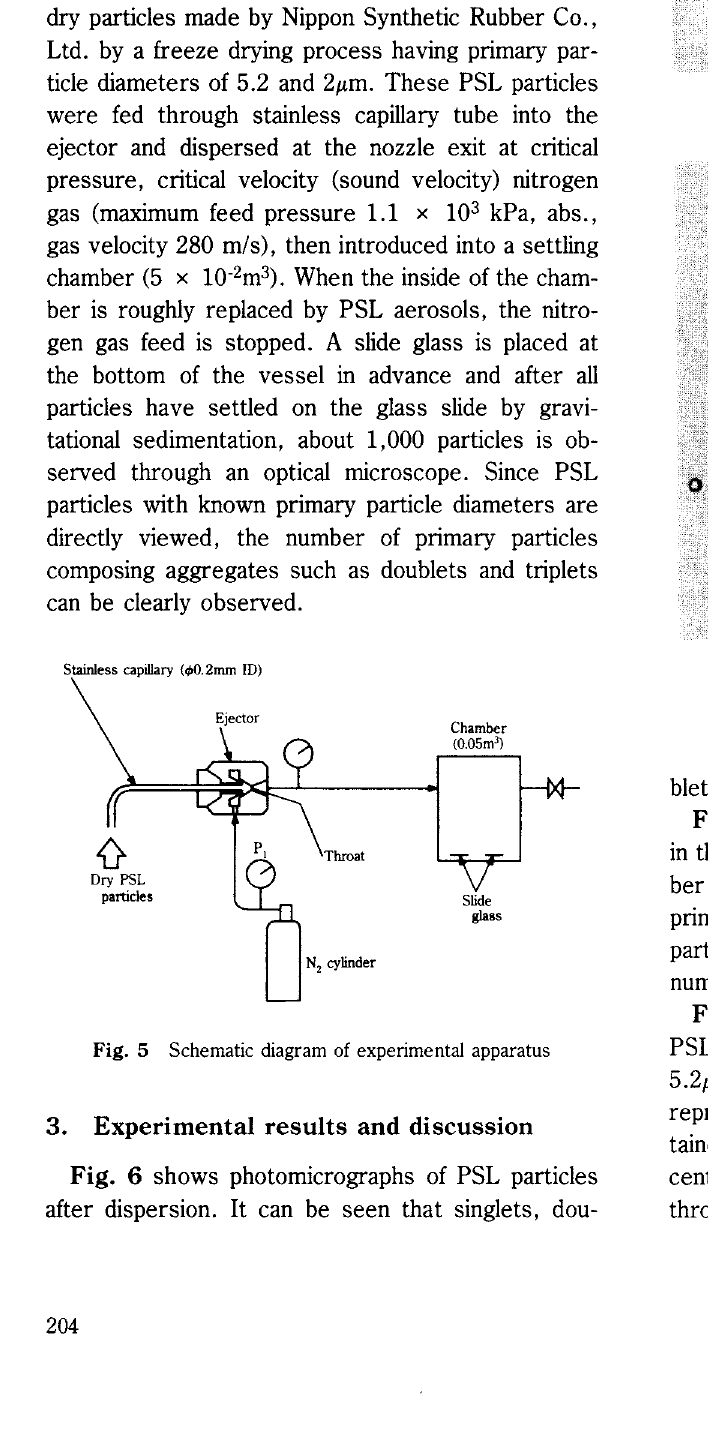
Fig. 5 Schematic diagram of experimental apparatus